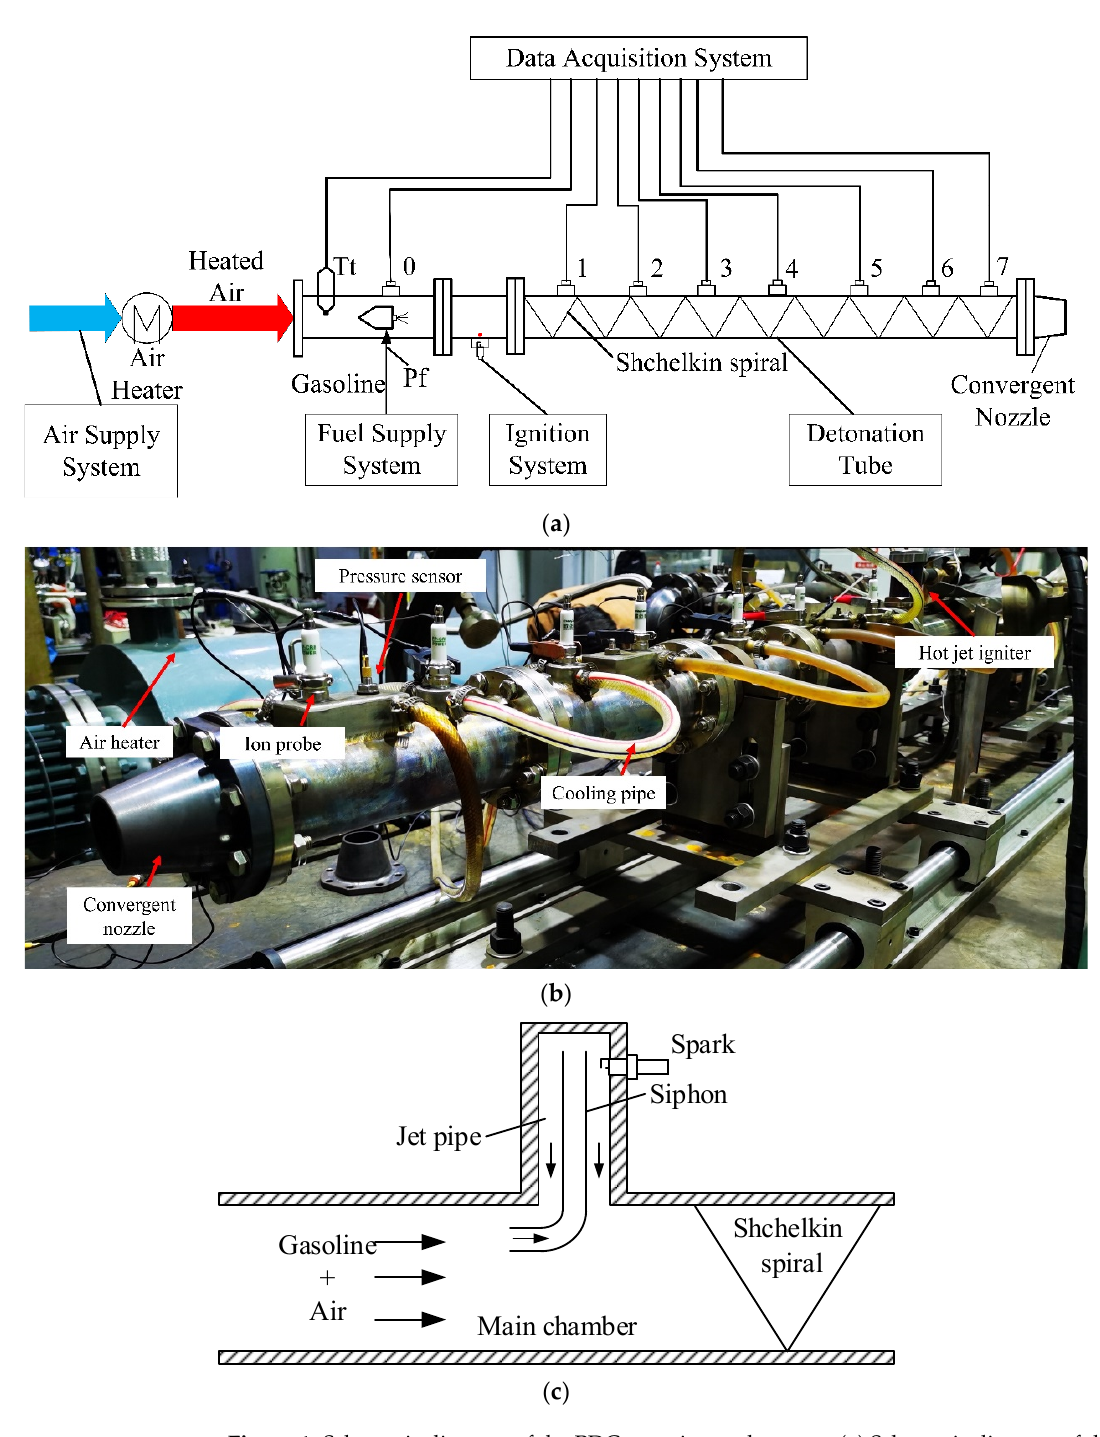
Figure 1. Schematic diagram of the PDC experimental system. ( a ) Schematic diagram of the valveless two-phase PDC test system. ( b ) The valveless two-phase PDC test system. ( c ) Hot jet igniter.